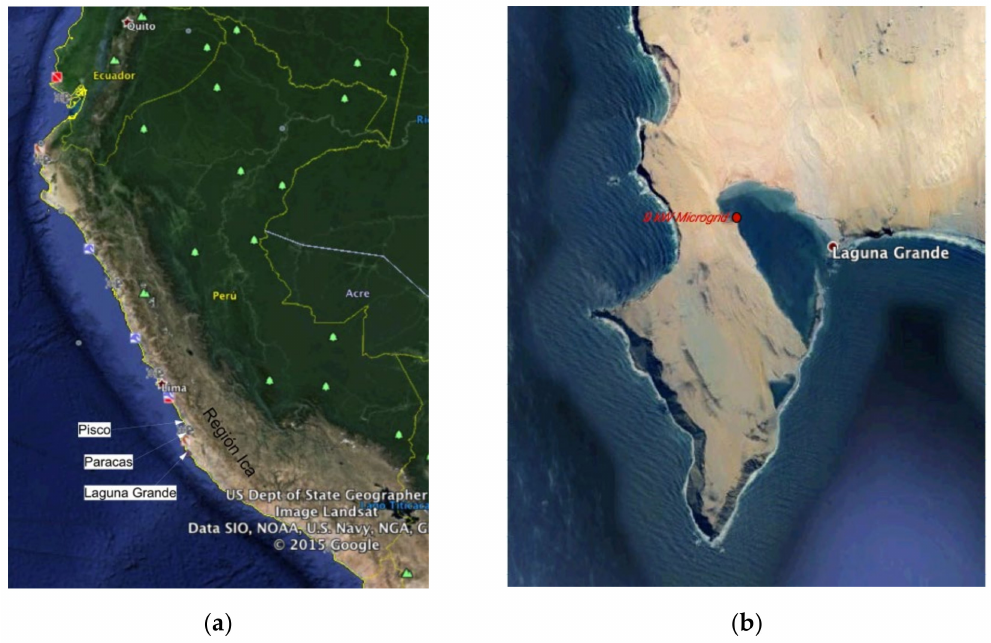
Figure 2. ( a ) Coastline of Per ú showing the location of the Ica region and Paracas; ( b ) detail of Laguna Grande and the location of the 9 kW microgrid. (14 ◦ 08 (cid:48) 50” S, 76 ◦ 16 (cid:48) 06” W. Reference: Google Earth.)